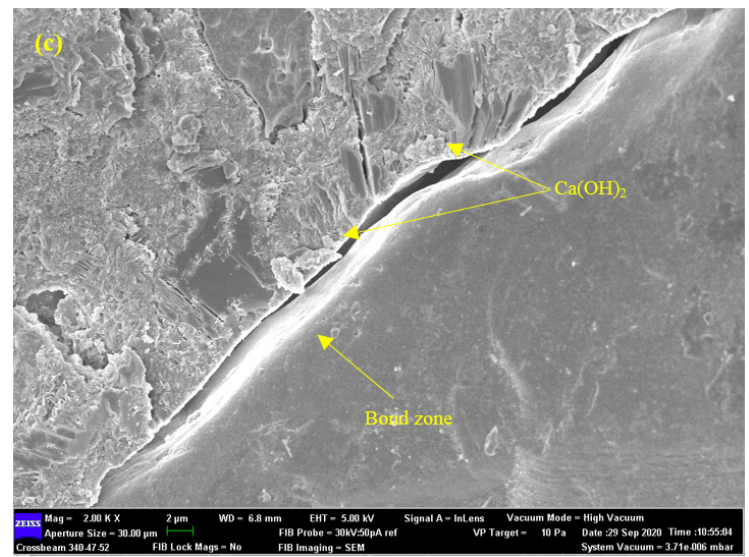
Figure 15. SEM image of ( a ) R 1 30CP20, ( b ) R 2 30CP20, and ( c ) R 3 30CP20 specimens.